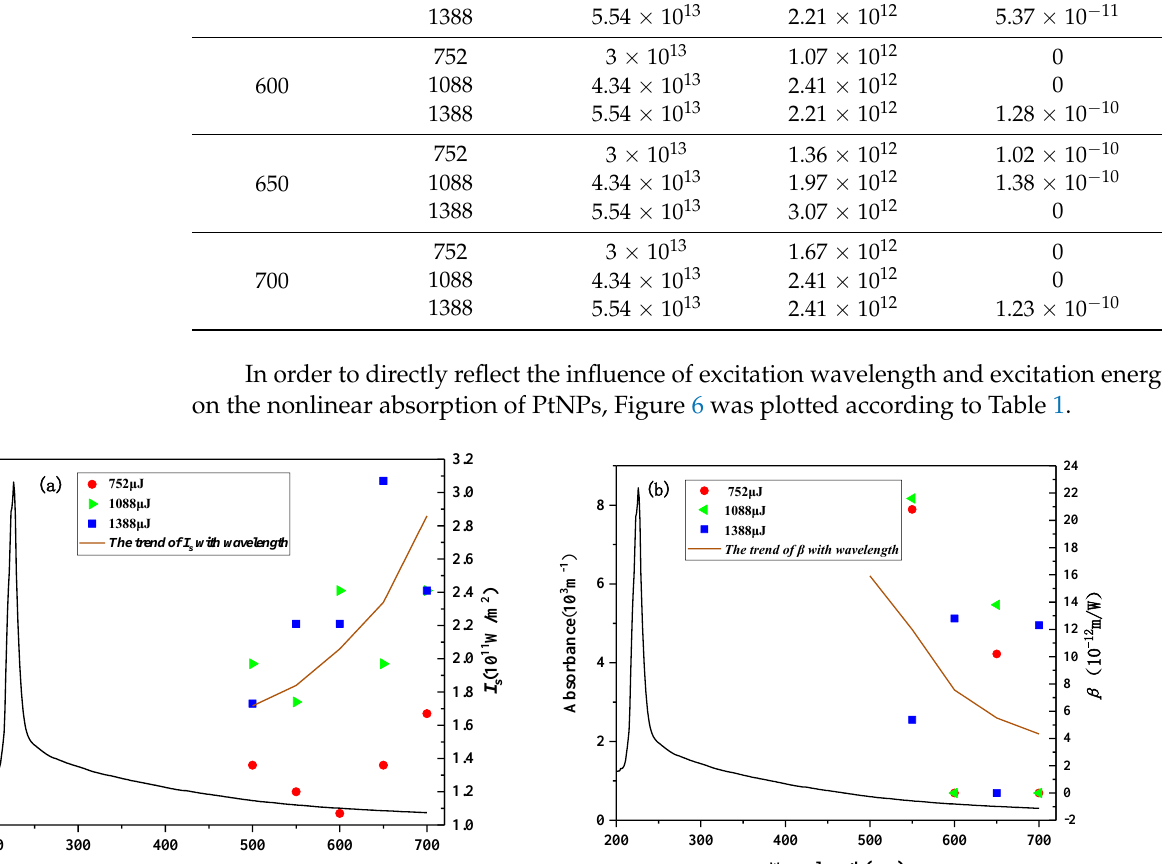
. ( b ) The relation- 𝑠